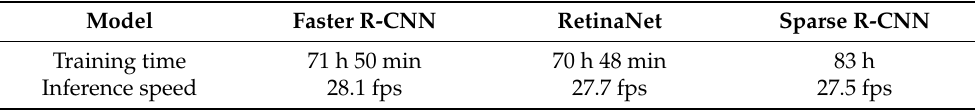
Table 4. Model training time and detection speed.